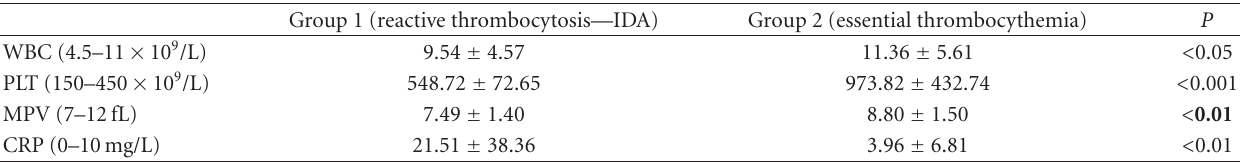
Table 3: Comparison of thrombocyte parameters, WBC, and CRP.